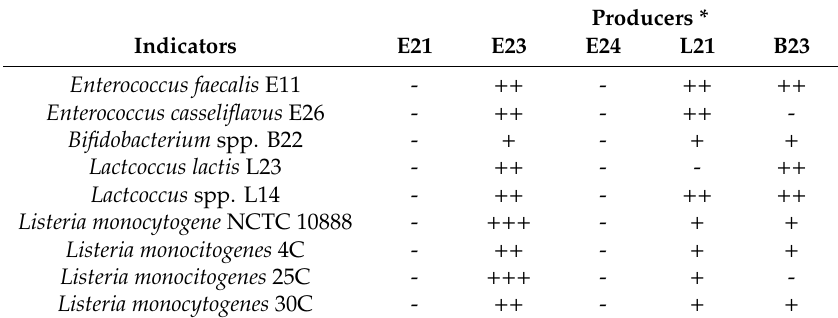
Table 1. Antibacterial activity of the five best bacteriocin producer strains detected in cell-free supernatant fluid by agar well di ff usion assay.